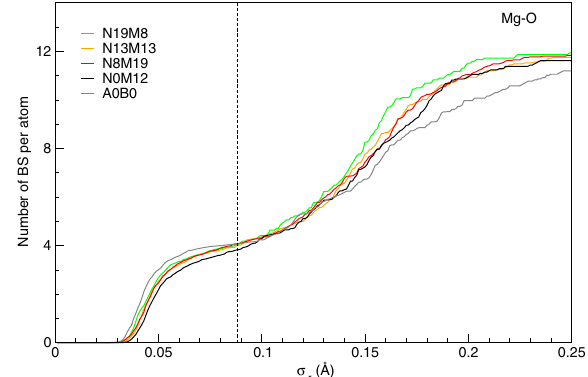
Fig. 7 Number of BS constraints for magnesium in the different glasses, as a function of radial excursion. Dashed lines correspond to the threshold values for the enumeration of the